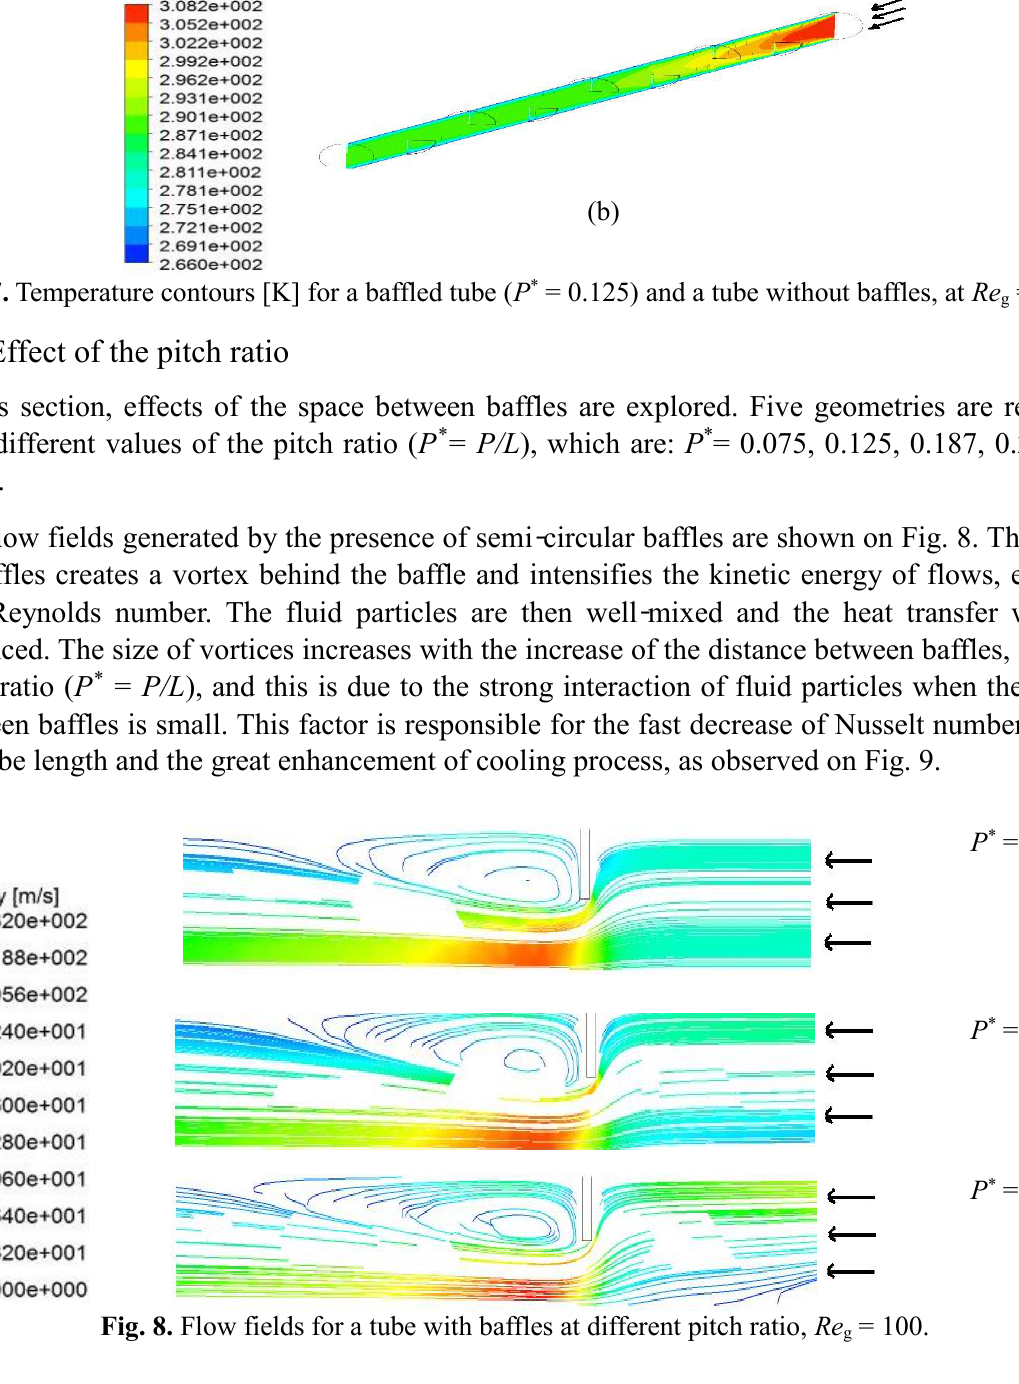
Fig. 7. Temperature contours [K] for a baffled tube ( P * = 0.125) and a tube without baffles, at Re